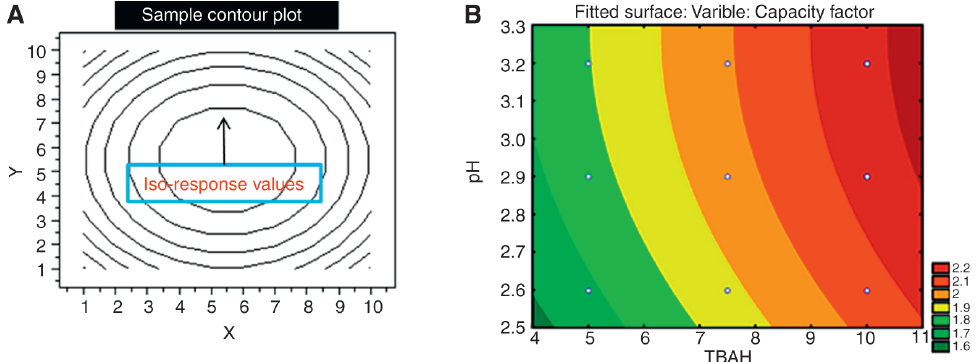
Figure 7: Contour plots: (A) effect of two independent variables X and Y on the respective axis toward a response represented collectively as iso-response lines (Grids). (B) Effect of concentration of TBAH on the capacity factor of eberconazole nitrate (Murthy et al.